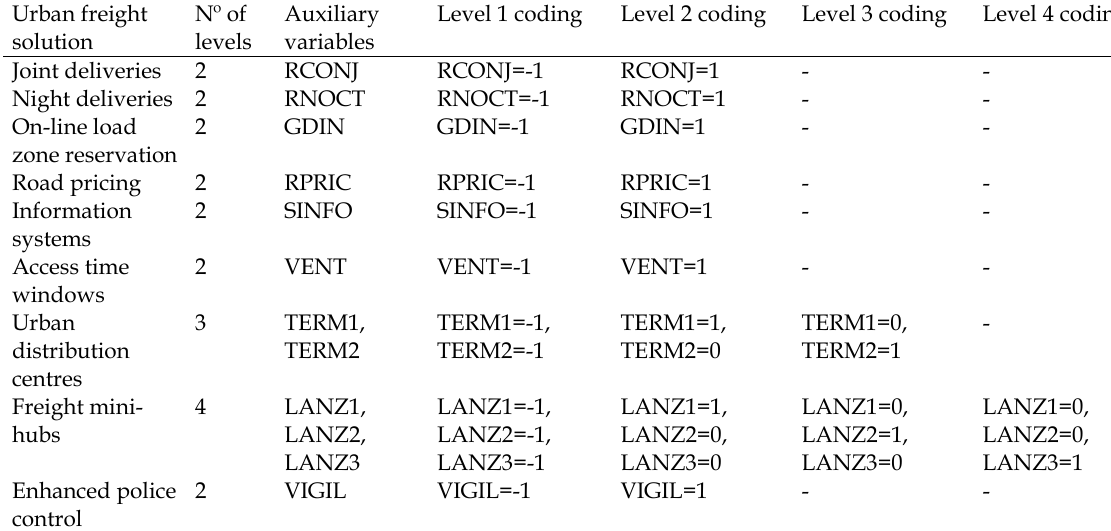
Table 3. Effects coding of the attributes in our analysis using 12